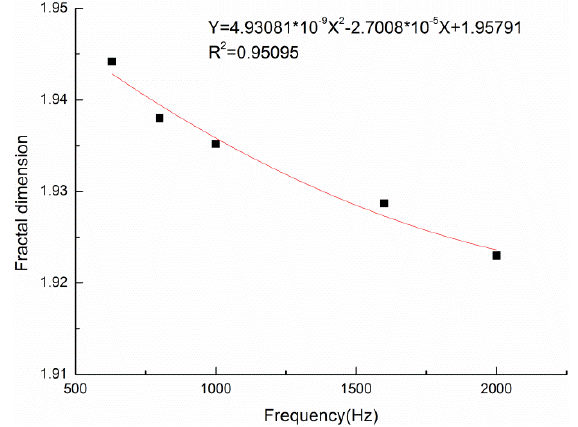
Figure 12. Relationship between fractal dimension and resonance absorption frequency.